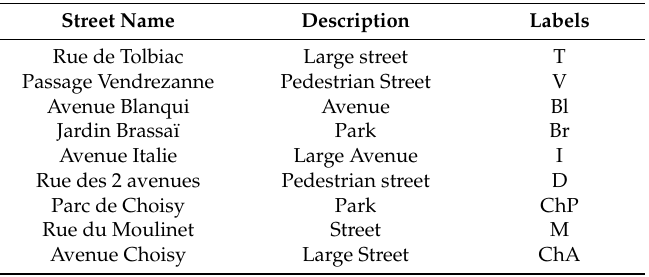
Table 1. Short description and labels for the travelled sound environments.